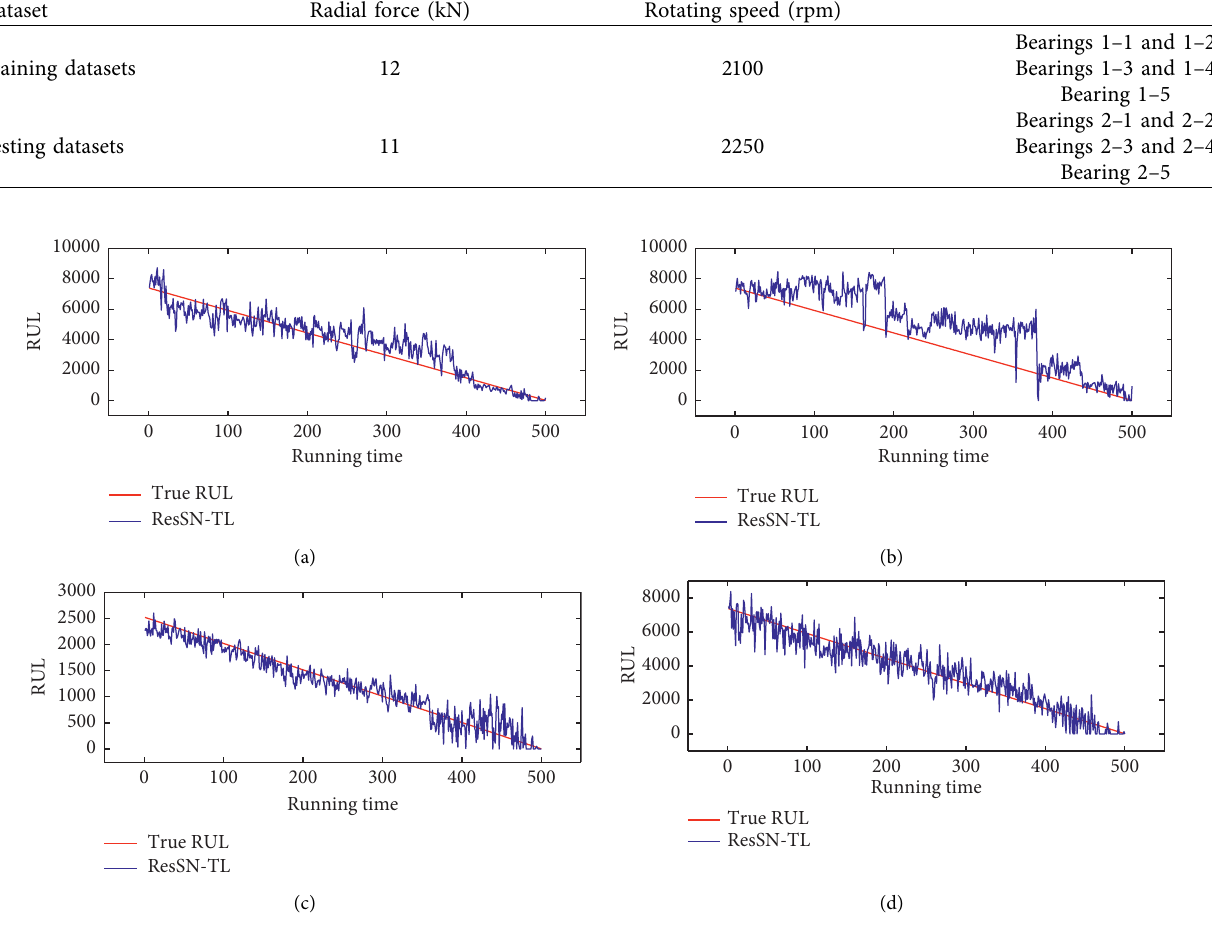
Figure 11: RUL prediction results of experimental data. (a) Bearing 2-1, (b) bearing 2–3, (c) bearing 2–4, and (d) bearing 2–5 experimental data. Table 6: RMSE results of